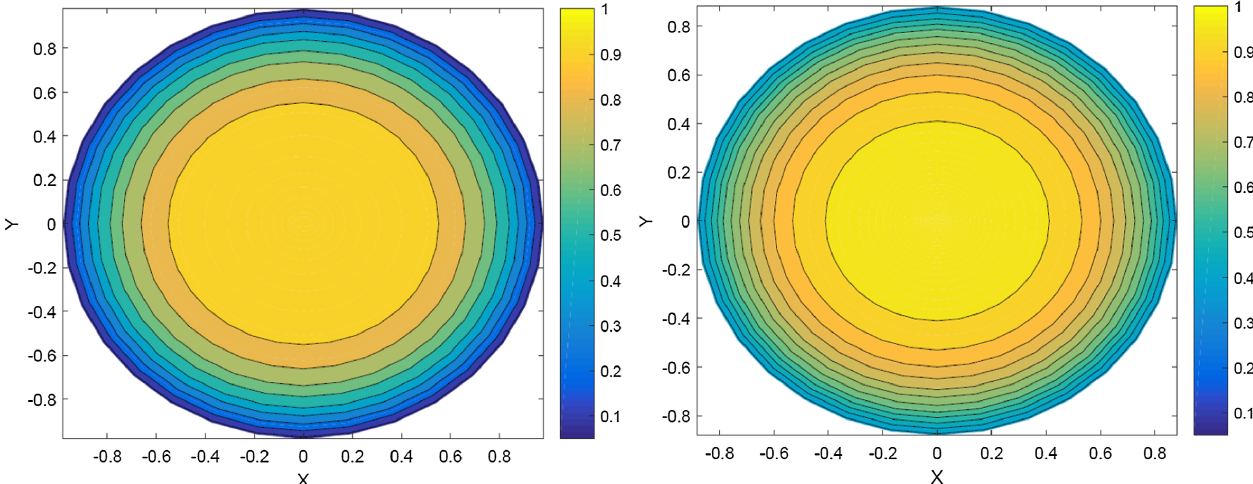
FIG. 2. Normalized electric potential distribution solution from the pseudospectral method (left) and from the second-order finite difference method (right) inside a nearly round conducting pipe.